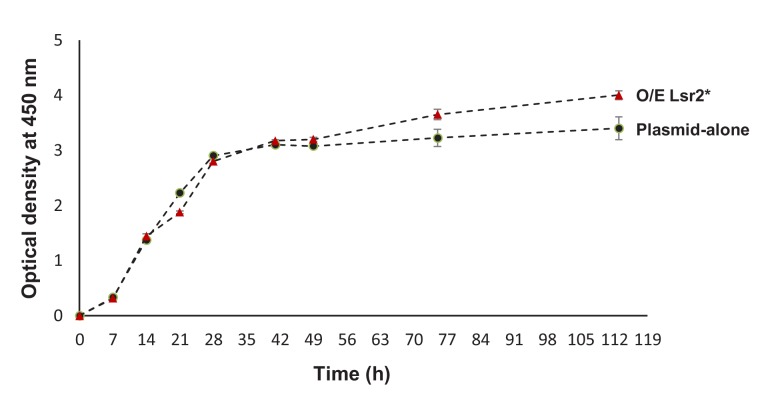
Growth curves of WAC04718 containing either an empty plasmid or one expressing Lsr2*.Strains were grown in Bennet’s medium for up to 120 hr, with optical density (at 450 nm) readings being taken at regular intervals. Experiments were conducted in duplicate, with standard deviation shown.